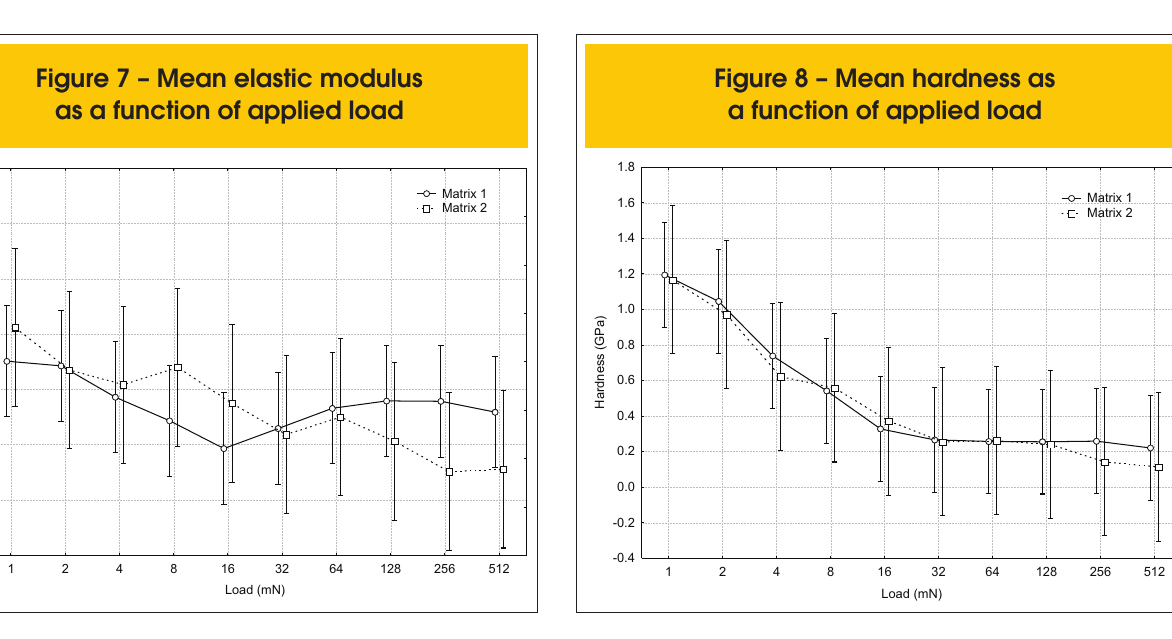
Matrix 1 Matrix 2